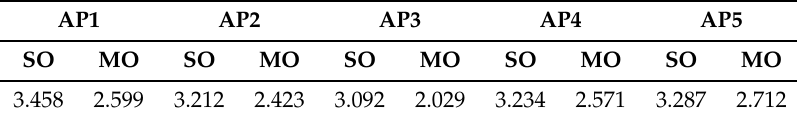
Table 1. Path loss exponent values of Static One (SO) and in-Motion One (MO) representations of all Access Points (AP).